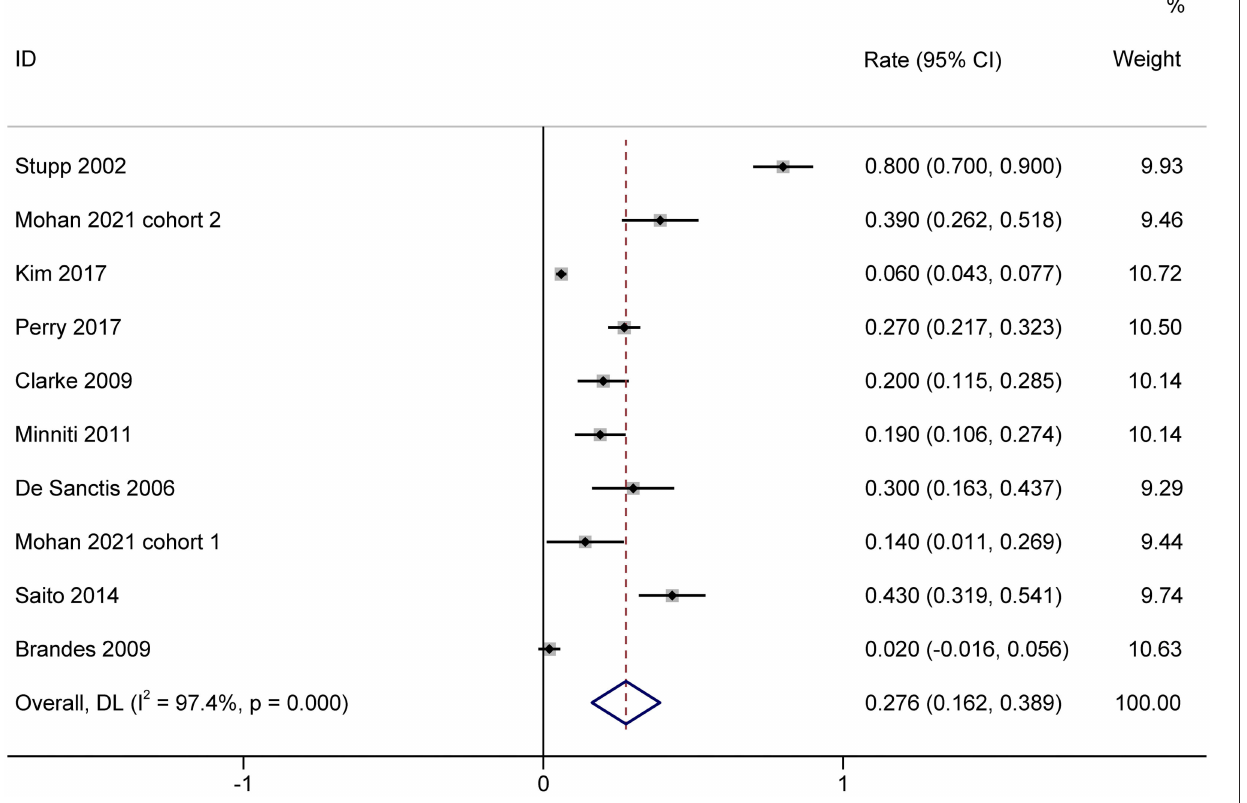
outcome-oriented cut point determination method. Rudra et